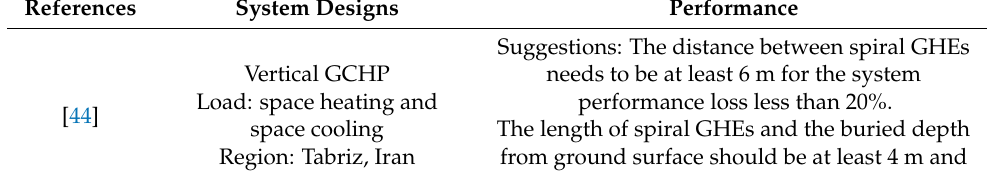
Figure 11. The schematic of the DX-GSHP system in heating mode.